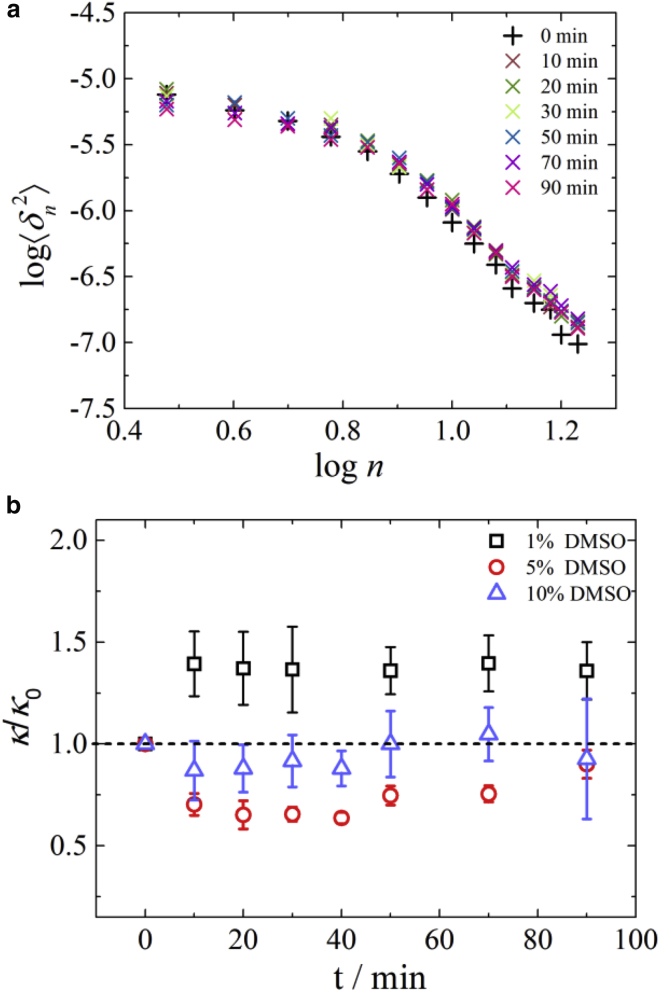
(a) Typical evolution in the thermal fluctuation spectrum of an individual RBC over time upon the addition of 5% v/v DMSO. (b) Time dependence of the sample averaged bending modulus of RBCs for three DMSO concentrations, 1% v/v (black squares). 5% v/v (red circles), and 10% v/v DMSO (blue triangles). The values of κ are normalized to the corresponding bending modulus, κ0, for each individual cell before the addition of DMSO. Averaged seven cells for 1% v/v DMSO, five cells for 5% v/v DMSO, and seven cells for 10% v/v DMSO. The error bars represent the standard error. To see this figure in color, go online.